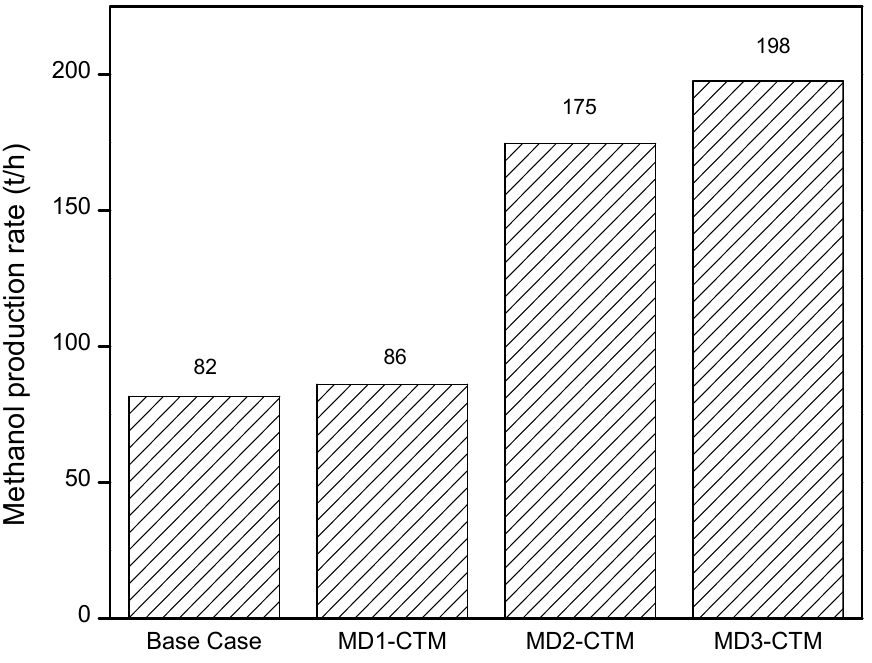
Figure 9. Methanol production rates for the four CTM processes.